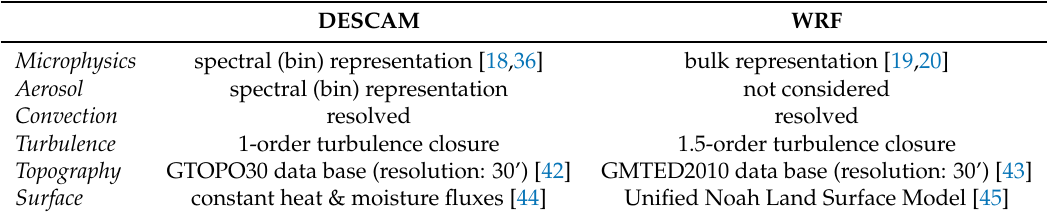
Table 1. Description of the most pertinent DESCAM and Weather Research and Forecasting (WRF) physical characteristics for this study (assumptions for microphysics, aerosol and convection representation; databases and resolution used for the topography; surface